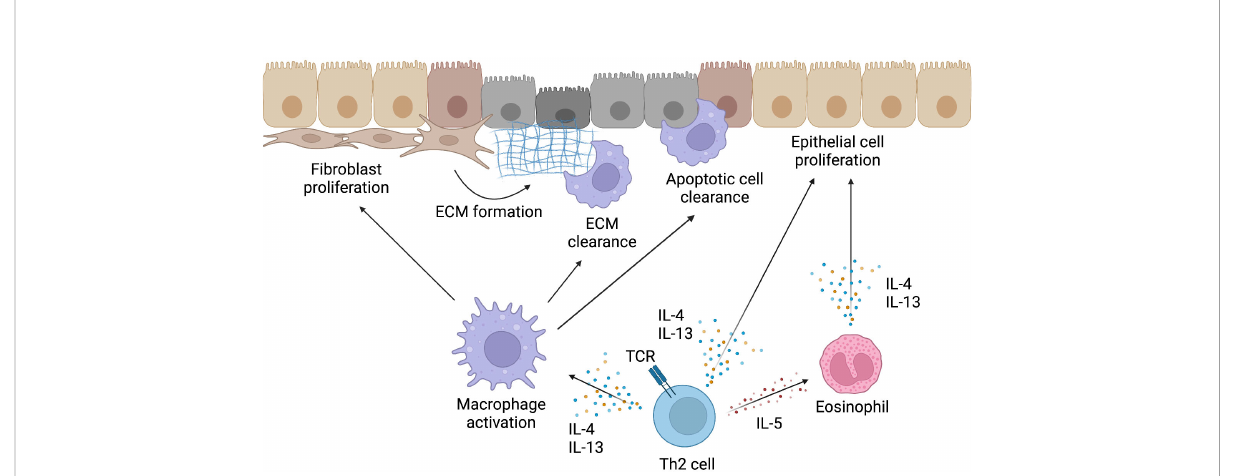
FIGURE 3 Mechanism of tissue repair by Th2 cells. Type 2 cytokines produced by Th2 cells not only induce type 2 in fl ammatory responses but also contribute to the repair of injured tissues. The activation of macrophages by IL-4 and IL-13 is important for the resolution of the type 2 in fl ammatory response and initiation of tissue repair. Activated macrophages induce fi broblast proliferation, remove extracellular matrix (ECM) formed by fi broblasts and other cells, and clear apoptotic cells in injured tissues. IL-4 and IL-13 produced by Th2 cells can also directly induce the proliferation of epithelial cells and contribute to the reconstruction of injured tissues. Furthermore, eosinophils, which are recruited to in fl ammatory sites by IL-5 produced by Th2 cells, can also produce IL-4 and IL-13. Thus, Th2 cells induce tissue repair both directly and indirectly. This fi gure was created with